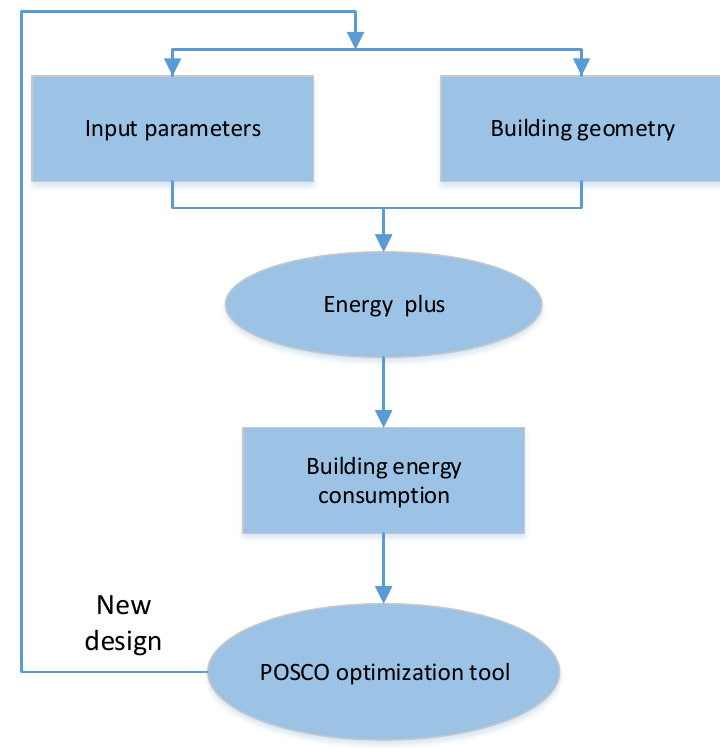
Figure 1. Ideal building energy optimization tool framework.